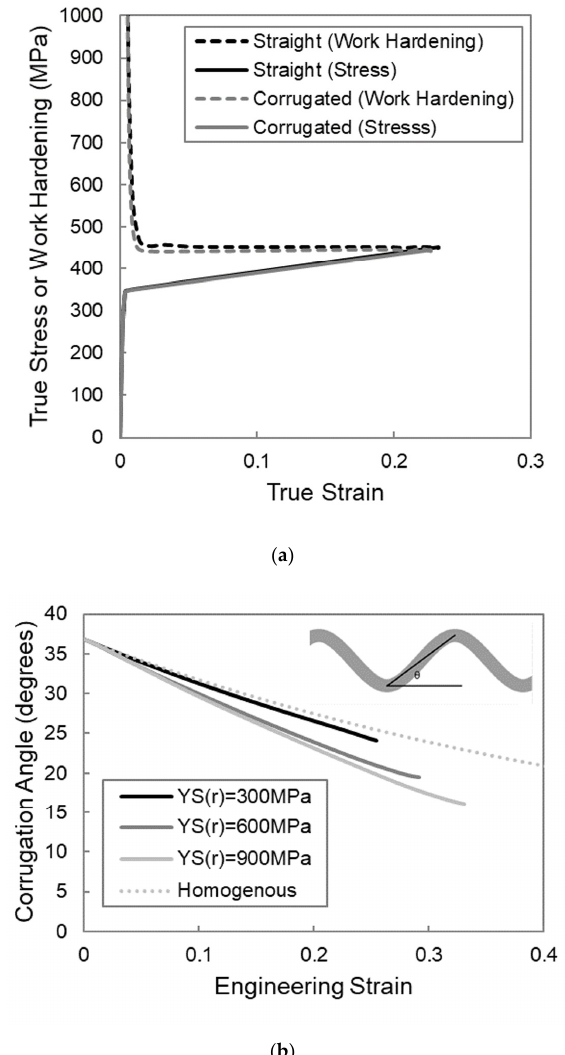
Figure 6 . ( a ) Work hardening and stress as a function of strain for both straight and corrugation-reinforced composites that have a low reinforcement yield strength, KS(r), of 300 MPa, which is below the threshold value. ( b ) Evolution of the corrugation angle, θ, for corrugation reinforced composites with different reinforcement yield strengths, KS(r). This plot also includes the angle evolution for a homogenous system in which the corrugation is the same material as the surrounding matrix.